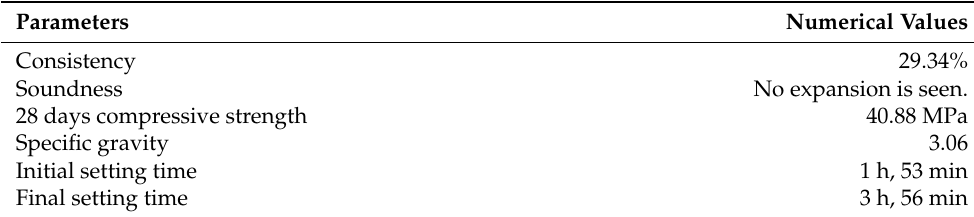
Table 1. Properties of ordinary Portland cement